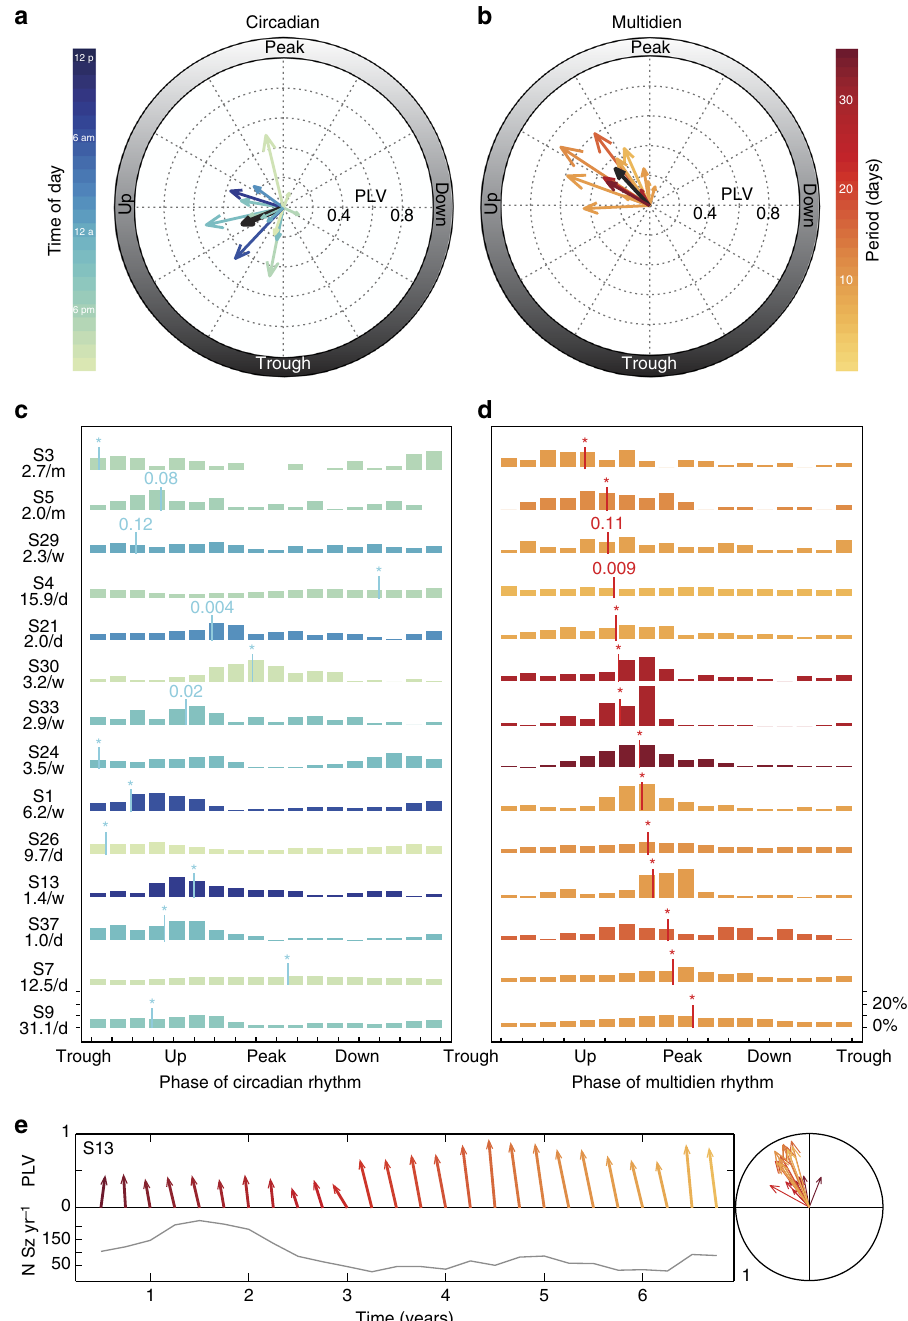
Fig. 4 Phase preference of seizures in relation to underlying IEA rhythm. Seizure timing relative to phase of the underlying circadian ( a ) or multidien ( b ) rhythm for each subject shown as the PLV and resultant angle ( N = 14; p -values in ( c , d ), Omnibus test, see Methods section). On average, the PLV was not different ( p = 0.63, Wilcoxon test), but the angles were more tightly distributed and closer to the peak for the multidien as compared to the circadian rhythm ( p = 0.002, Kuiper two-sample test, see Methods section). For visualization purposes, individual circular histograms of seizure counts (percentage of total count) for circadian ( c ) and multidien ( d ) rhythms are shown, ranked according to increasing multidien average phase (vertical bar position). p- values for the Omnibus test shown in Figure. * p < 0.001. Color codes in ( a ) and ( c ) are the same as in Fig. 3 and represent hour of the day of peak circadian rhythm. Color codes in ( b ) and ( d ) represent peak periodicity of multidien rhythm, illustrating that the preferred multidien phase is similar, regardless of the exact period length. e Feather and polar plots showing stable direction and magnitude of phase preference assessed every 3 months in one subject (S13). Color-coding establishes data correspondence between feather (left) and polar plot (right) and does not refer to color-bars in ( b ). The annual number of seizures is displayed to show the decrease over years of treatment with the RNS System and the number of seizures included in each